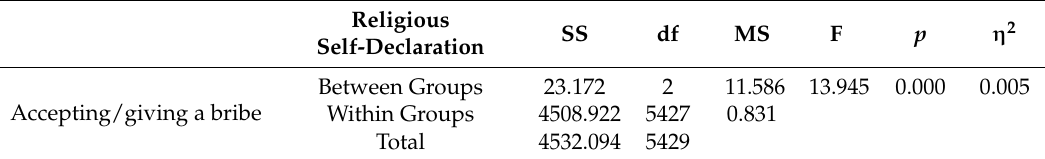
Table A9. Accepting/giving a bribe among religious self-declaration.